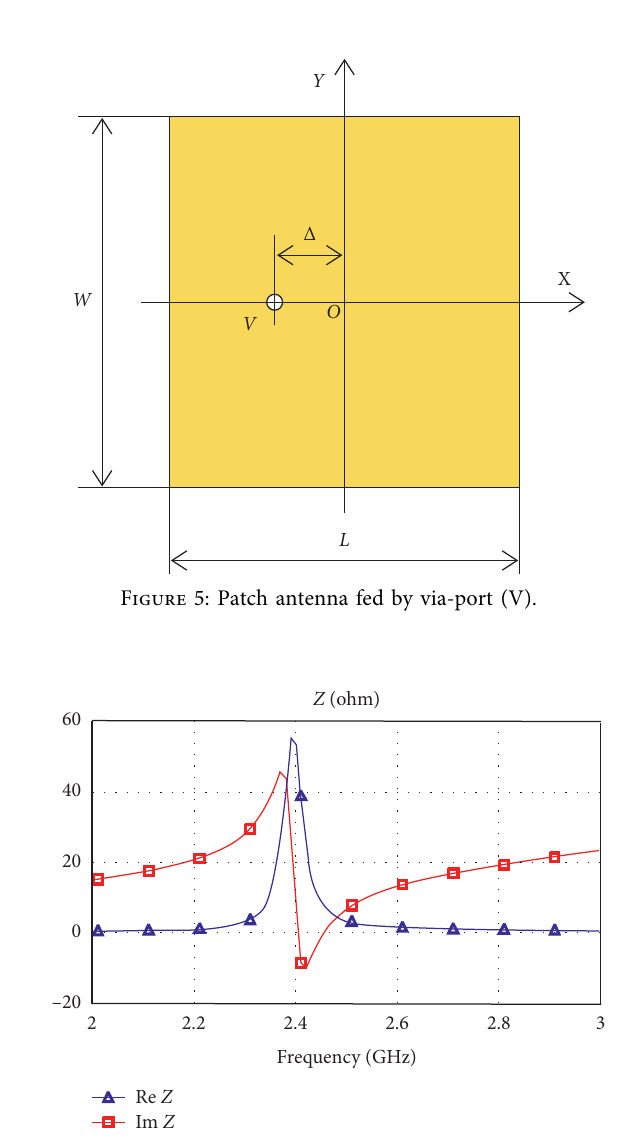
Figure 4: A wireless connection using two active antennas.